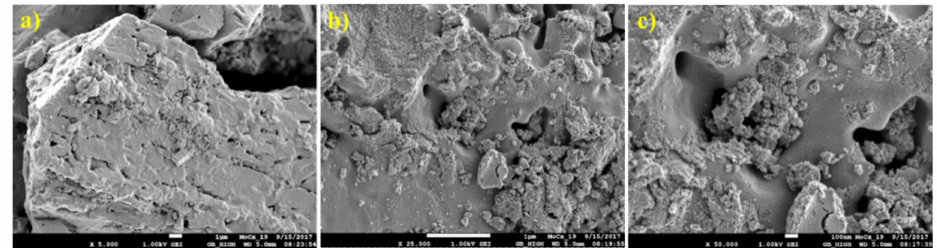
Figure 9. SEM images of molybdenum carbides synthesised from HMT-AHM-600 at magnifications of ( a ) 5000 × , ( b ) 25,000 × , and ( c ) 100,000 ×